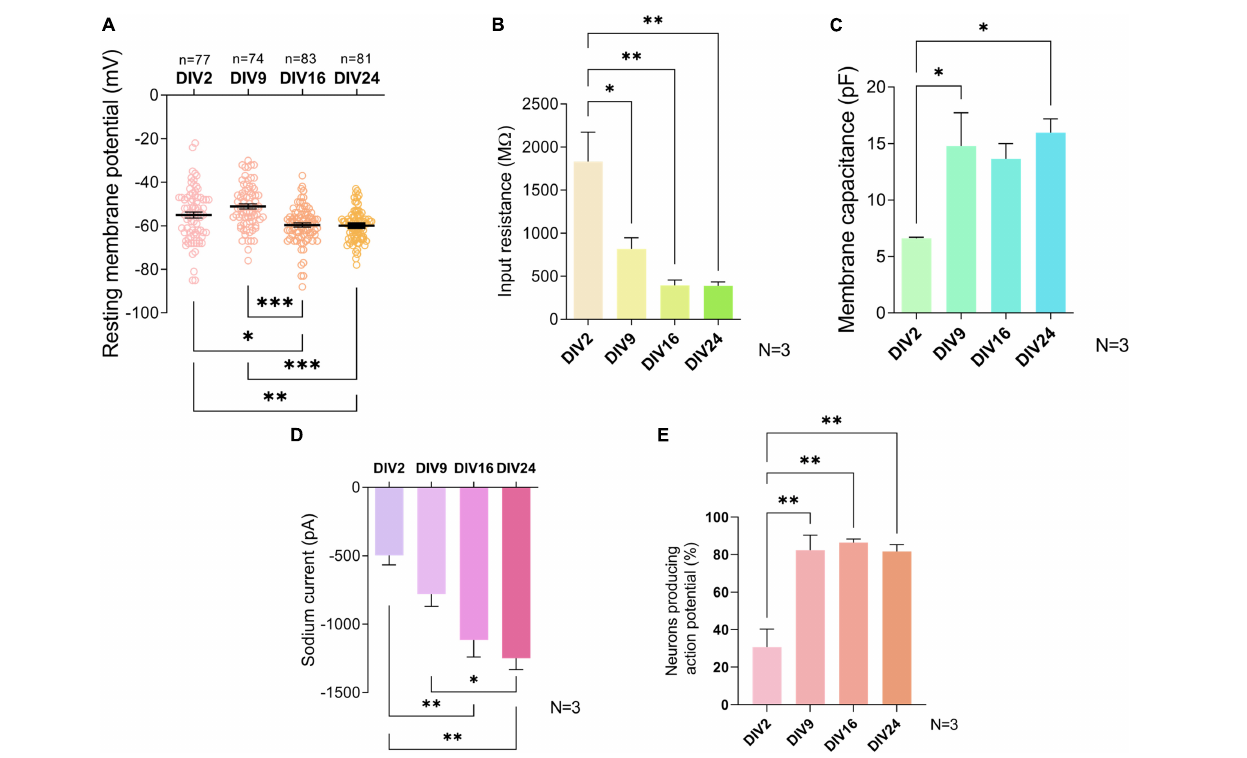
FIGURE 3 | Electrophysiological properties of cultured neurons during maturation. Resting membrane potential (A) and sodium current (D) did not change significantly after day in vitro (DIV) 16. Input resistance (B) , membrane capacitance (C) , and the percentage of neurons producing action potentials (E) did not change significantly after DIV9. Data are presented as means ± SEM of N = 3 biological replicate cultures and n number of cells; ∗ p < 0.05, ∗∗ p < 0.01, ∗∗∗ p <